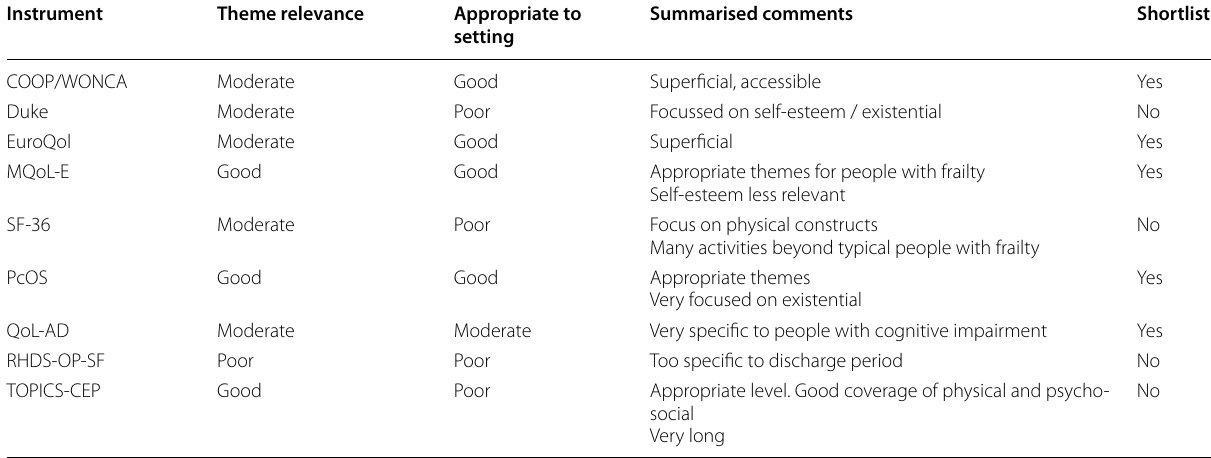
Table 5 Instrument face validity informing reduction of a shortlist